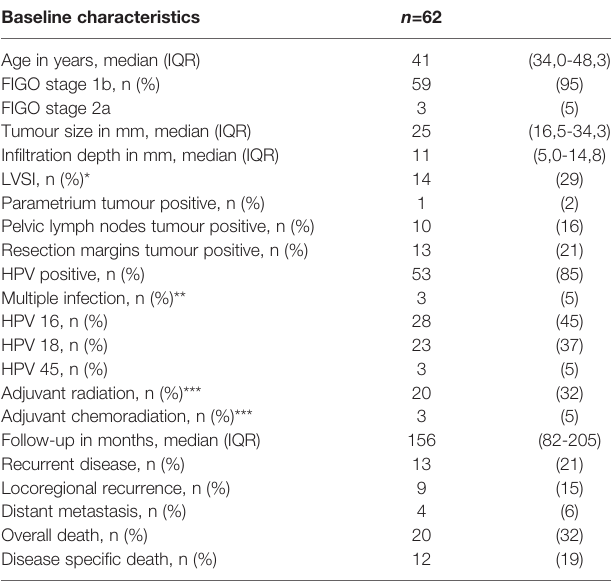
TABLE 1 | Baseline characteristics of the institutional AC cohort. Baseline characteristics